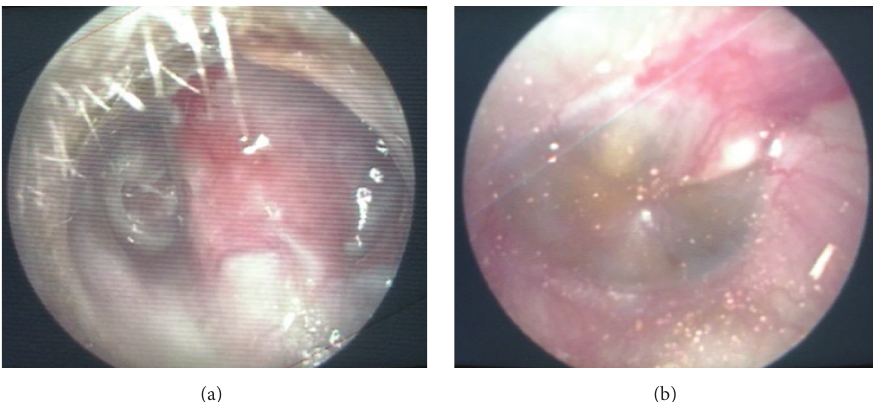
Figure 2: (a) Left otoscopy showing mucopus at the mastoid cavity and external auditory canal. (b) Right inflamed and dull tympanic membrane.